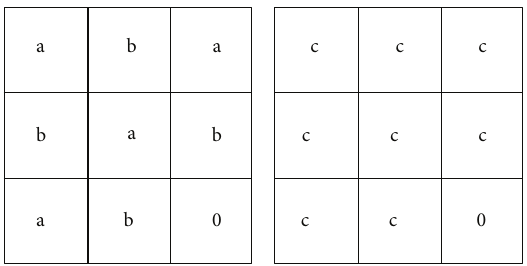
Figure 2: The convolution kernels proposed by Hadhoud et al. [27].